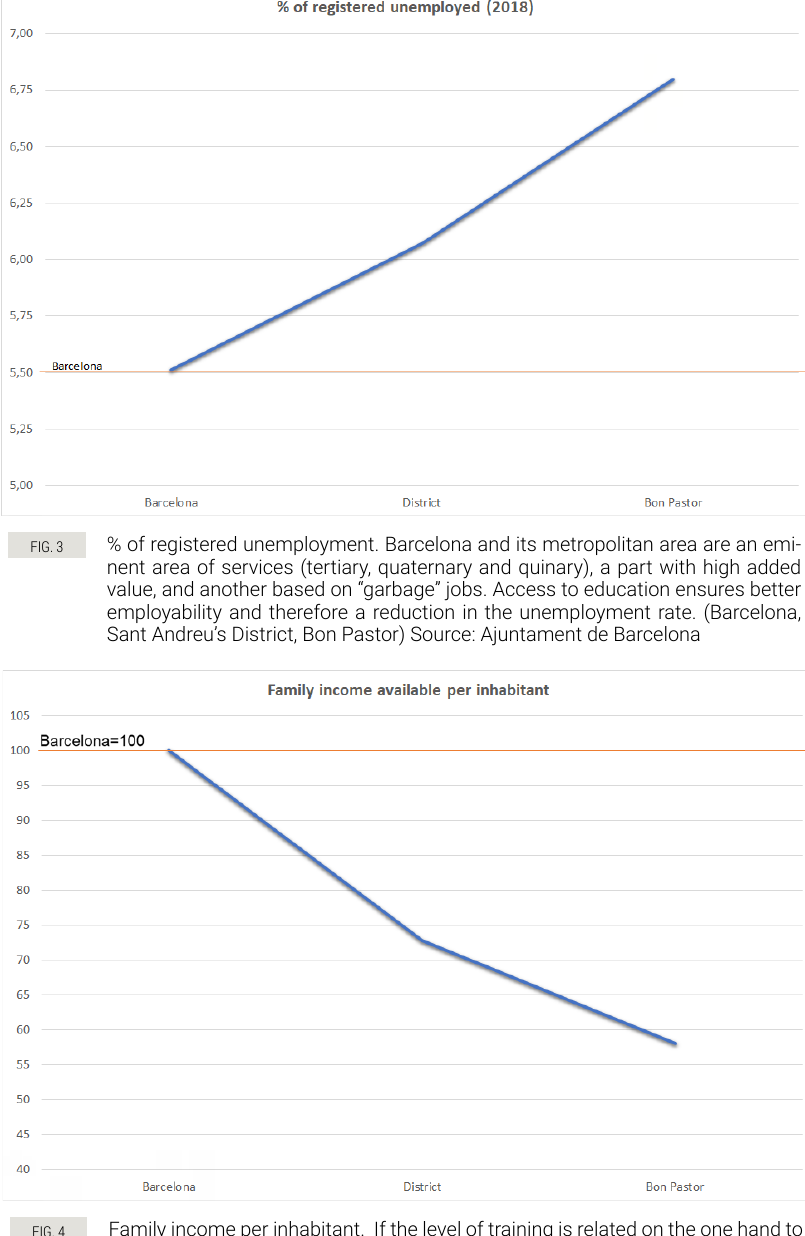
FIG. 4 Family income per inhabitant. If the level of training is related on the one hand to the risk of unemployment and on the other to the type of work and remuneration that can be achieved, it is logical that we find that the level of income is affected in this neighbourhood, almost 50 points below the 100 index for the whole city. (Barcelona, Sant Andreu’s District, Bon Pastor) Source: Ajuntament de Barcelona